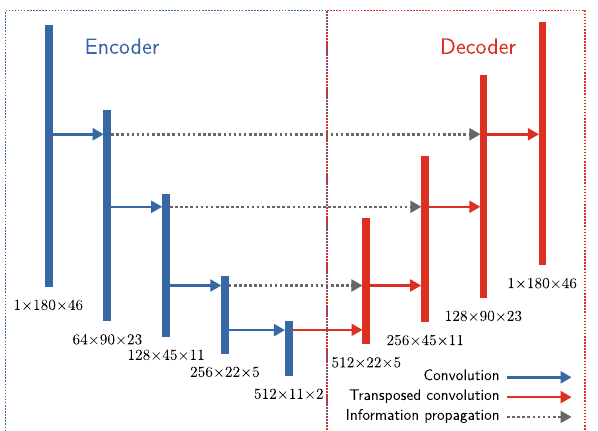
Figure 7. Basic U-Net-like architecture of the pole widths standardization algorithm. The numbers in the figure describe the dimensionality of the resulting tensors ( depth × height × width ) after applying the corresponding layer. The heights of the rectangles are arbitrary. The gray arrows depict the information propagation to a subsequent